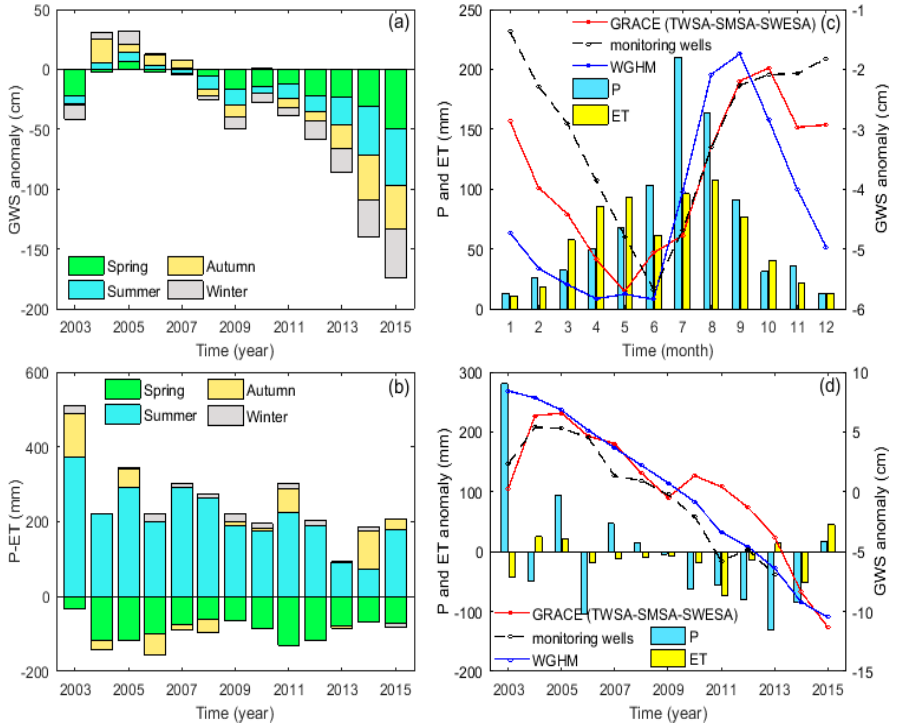
Figure 7. Temporal variations of GWSA in the 3H Plain during 2003 to 2015: ( a ) seasonal GWSA variations derived from GRACE; ( b ) seasonal P-ET (precipitation-evapotranspiration); ( c ) intra-annual changes in monthly GWSA derived from GRACE, monitoring wells, and WGHM. The blue and yellow bars represent the monthly average precipitation and evapotranspiration, respectively; and ( d ) inter-annual changes in GWSA derived from GRACE, monitoring wells, and WGHM. The blue and yellow bars represent the annual anomalies of precipitation and evapotranspiration, respectively.